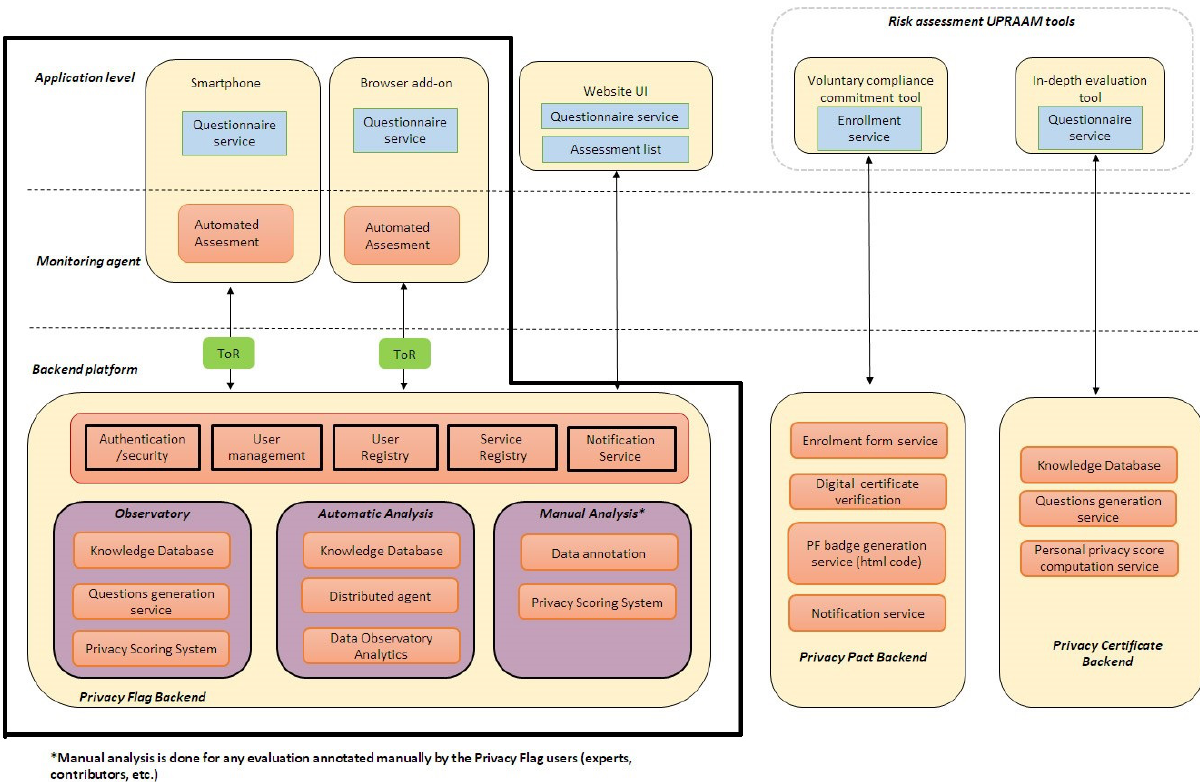
Figure 1. Overall platform